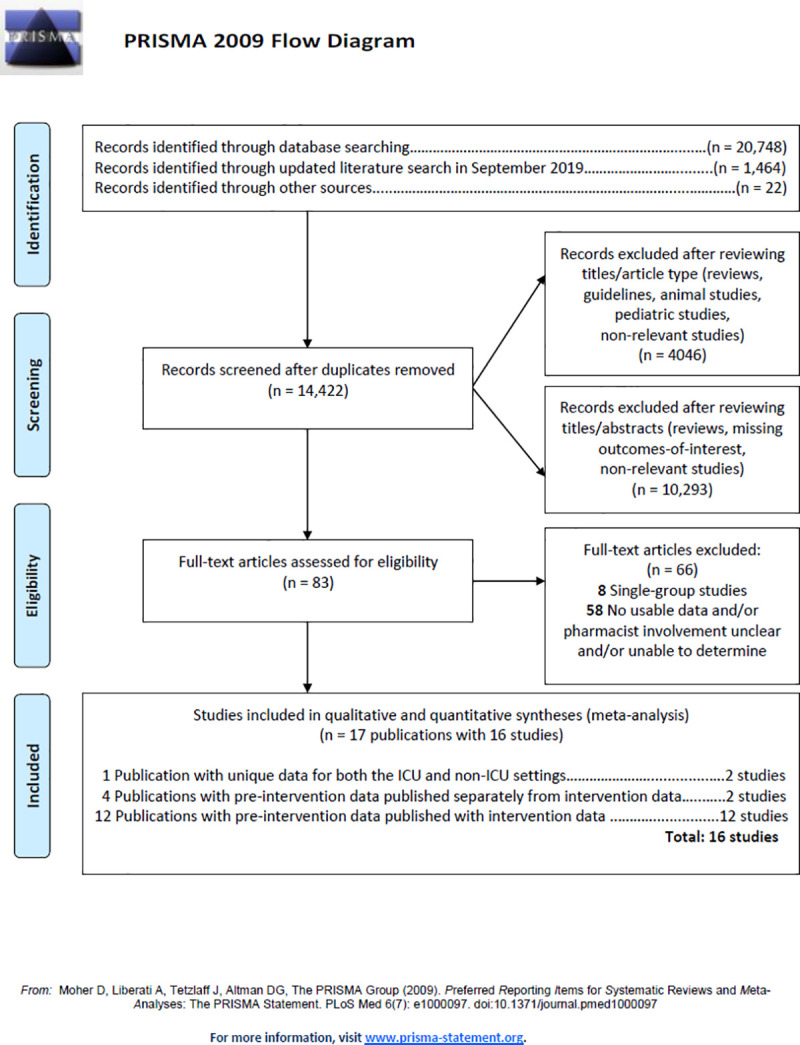
Flowchart of the literature search and study selection.